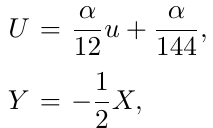
JHEP03(2020)136 + xt h 1 vs. t , t i